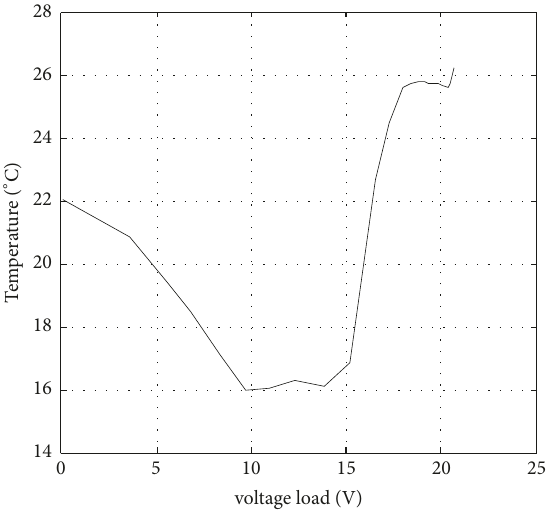
Figure 13: Variation of temperature with the load